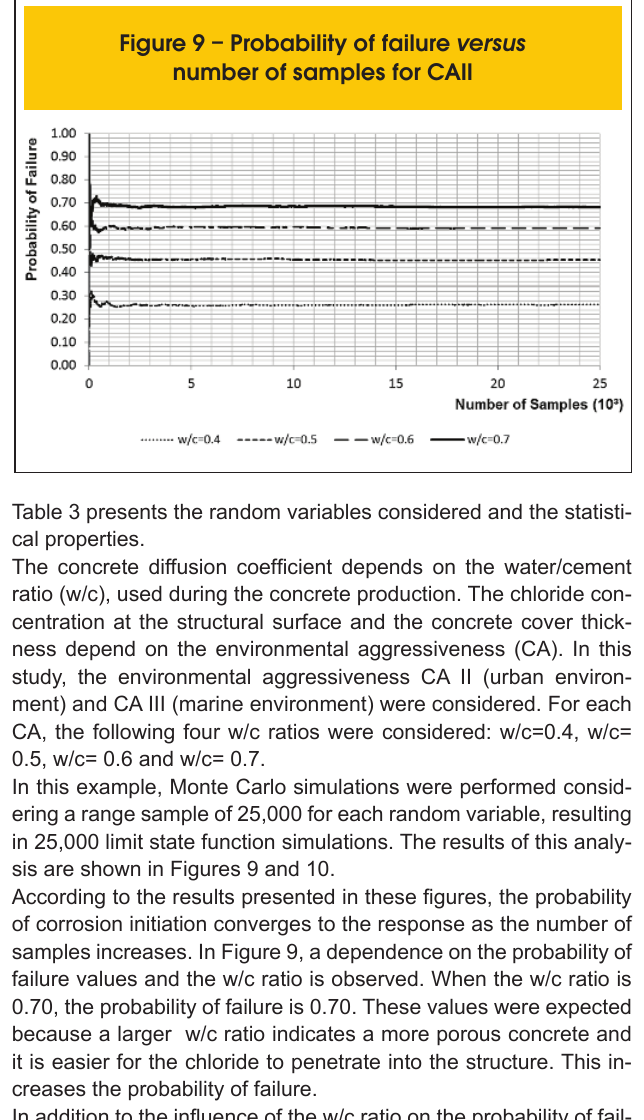
Figure 9 – Probability of failure versus number of samples for CAII